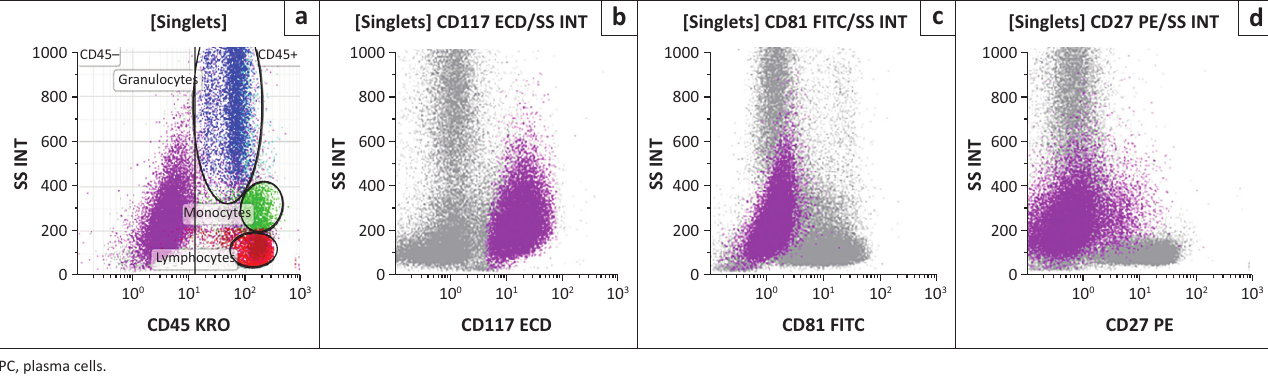
FIGURE 2: Identification of plasma cells using the DURAClone PC tube validated at the Charlotte Maxeke Johannesburg Academic Hospital flow cytometry laboratory in Johannesburg, South Africa, April 2020 to August 2020. In histogram a, negative CD45 expression of plasma cells is shown (purple), with CD45 positive (background) expression noted amongst granulocytes (blue), monocytes (green) and mature lymphocytes (red). The target plasma cell population were primary-gated on bright CD138 and CD38 to reveal aberrant CD117 expression (b) and under-expression of CD81 (c) and CD27